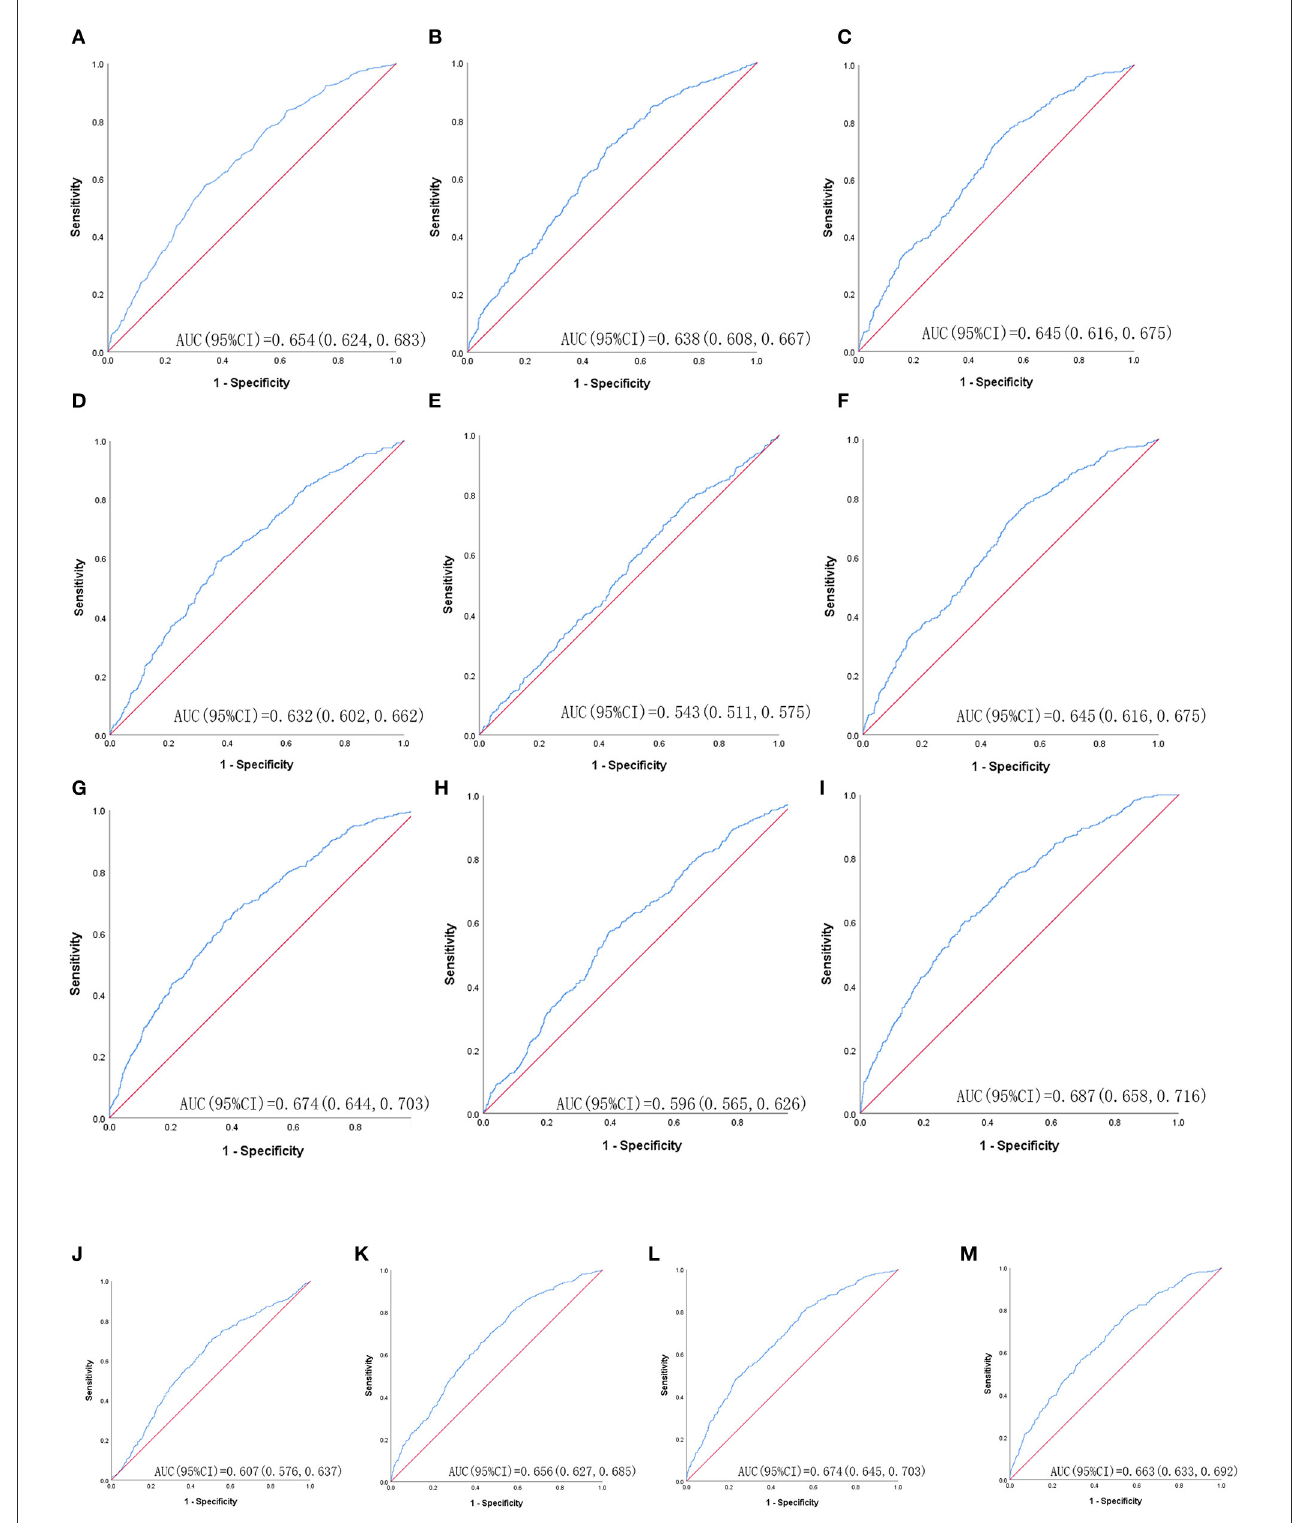
FIGURE4 The ROC curves of each indicator in the prediction of MetS risk in female. (A) = WC, (B) = BMI, (C) = WHtR, (D) = VAI, (E) = ABSI, (F) = BRI, (G) = LAP, (H) = CI, (I) = CVAI, (J) = TyG-index, (K) = TyG-BMI, (L) = TyG-WC, (M) = TyG-WHtR.